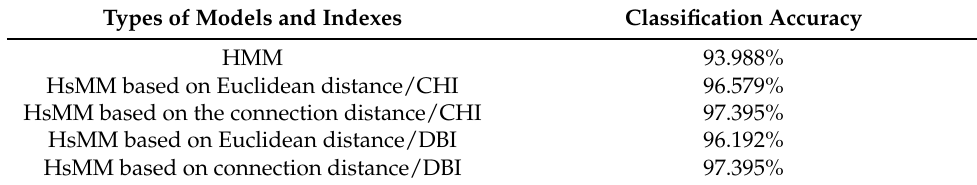
Table 3. Accuracy of state estimation in different models and index